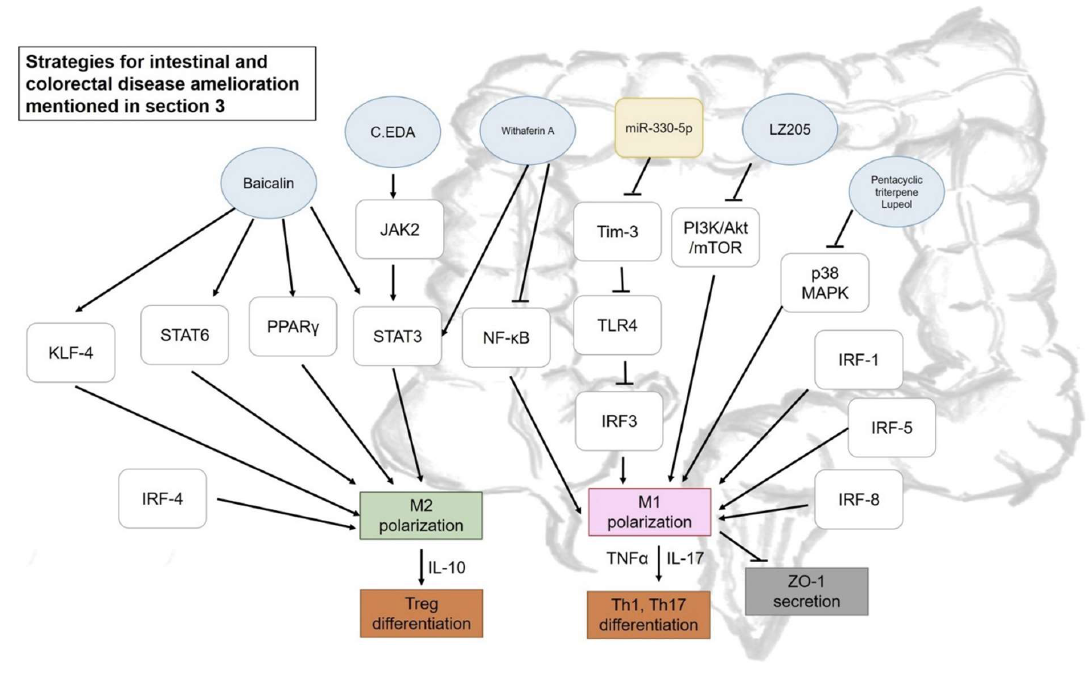
Figure 3. Some strategies proposed for intestinal and colorectal diseases amelioration mentioned in Section 3. Blue circle, samples intervened; yellow block, microRNA intervened; white blocks, genes/proteins involved.